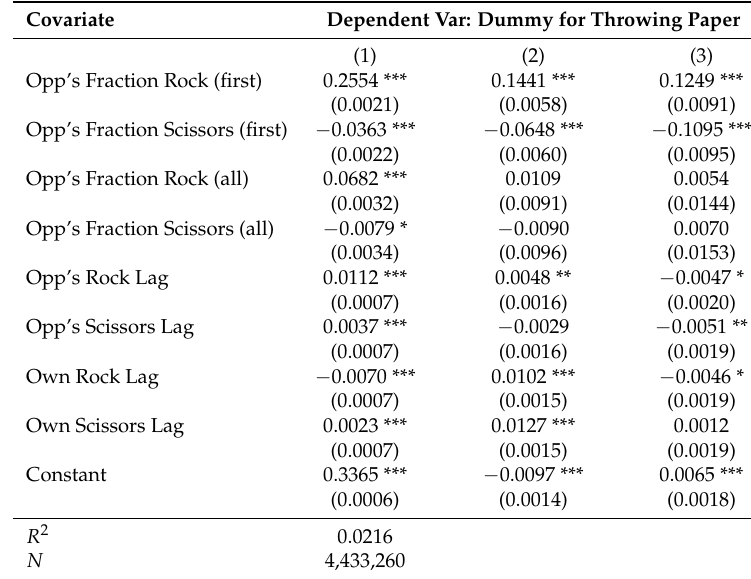
Table A4. Probability of Playing